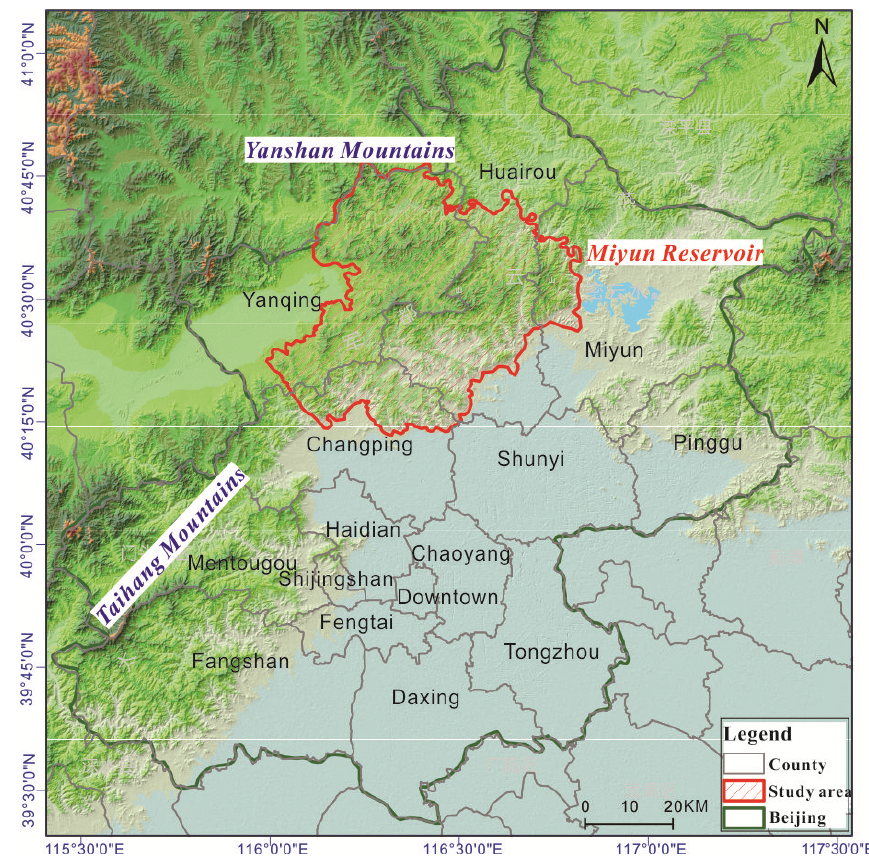
Figure 1. Schematic plot of the study area